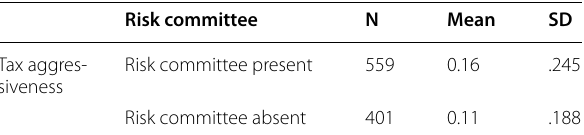
Table 4 Tax aggressiveness based on risk committee presence.